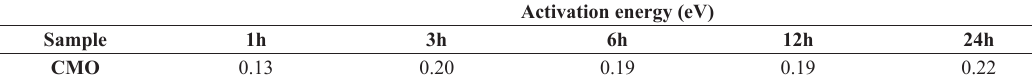
Table 3. Activation energy for CMO ceramics sintered at different holding times.